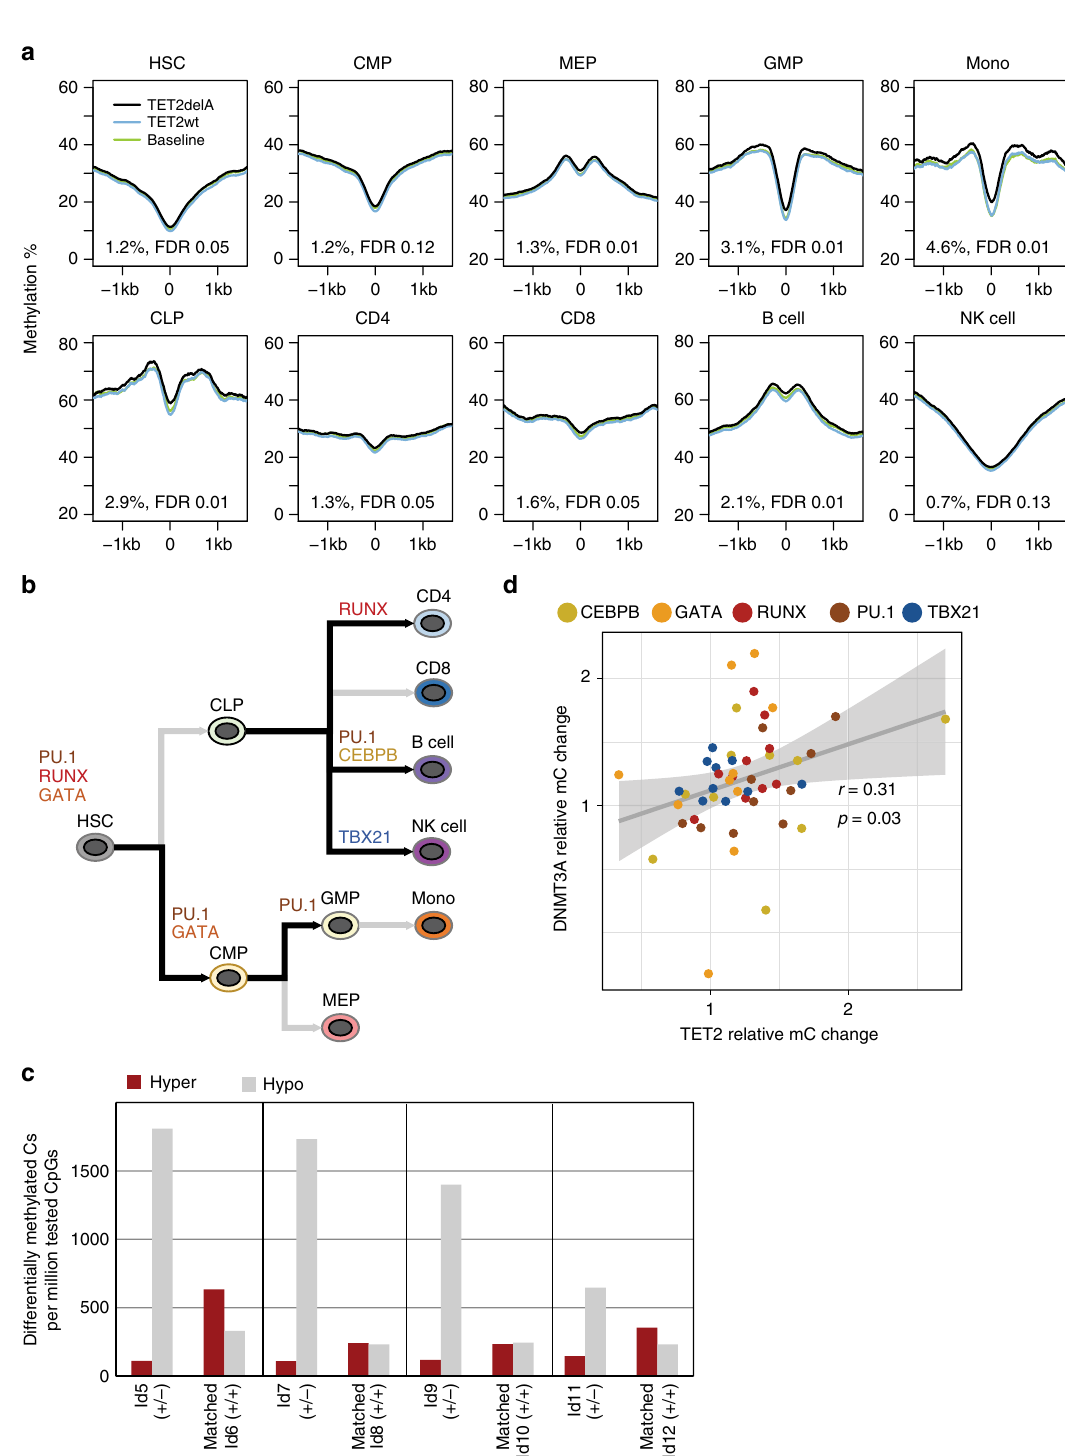
with expression changes of immunoglobulin genes, we detected signi fi cantly elevated methylation in a B-cell-speci fi c open chromatin region at the promoter of the IGHJ6 gene in TET2delA carriers (Supplementary Fig. 16, Supplementary Data 1). Analysis of regulon activity by looking at TFs and their co-expressed cis target genes revealed 26 TFs with signi fi cantly increased and 12 TFs with signi fi cantly decreased activity in cancer-free TET2delA carriers as compared to wild-type individuals, including TBX21 and EOMES that displayed lower activity especially